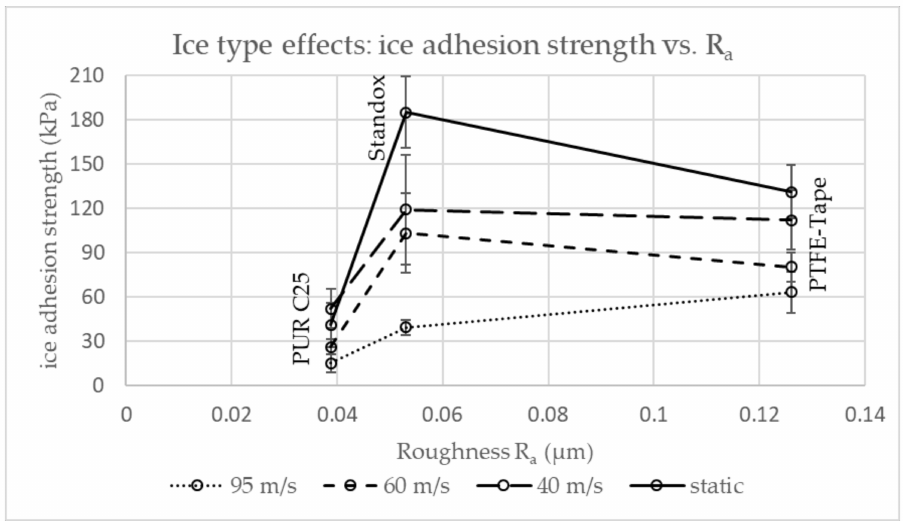
Figure 8. Surface parameter R a and ice adhesion strength data for different ice formation